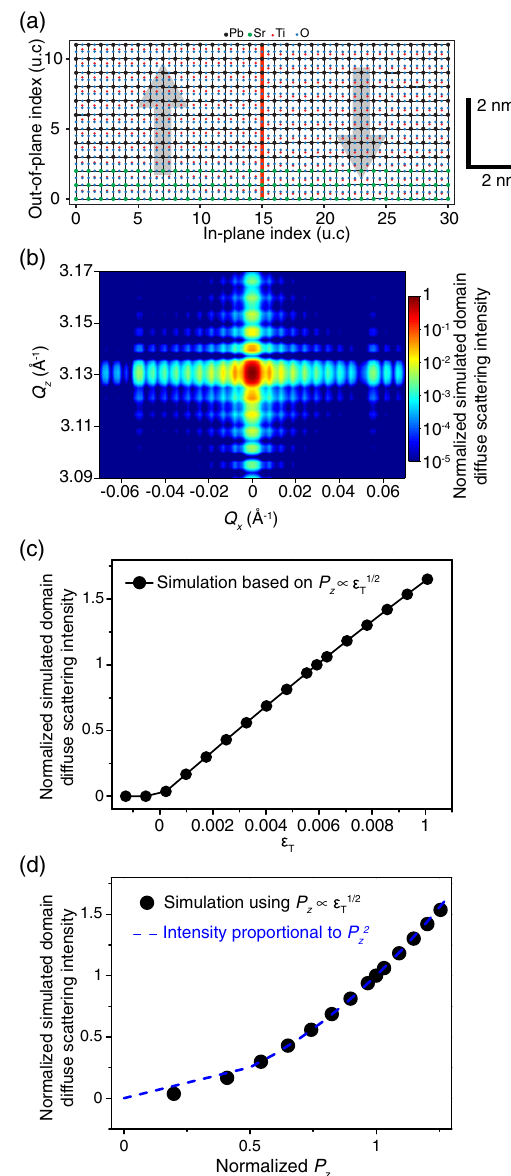
FIG. 8. (a) Atomic arrangement within a cell with a lateral size matching a single nanodomain period of one structural repeating unit of the PTO/STO SL. The solid line indicates the location of the boundary between up and down polarization regions. (b) Simulated distribution of scattered x-ray intensity in the Q x - Q z plane of reciprocal space in a region including the 002 SL Bragg reflection. Domain diffuse scattering intensity maxima appear at Q z ¼ 3 . 13 Å − 1 and Q x ¼ (cid:2) 0 . 054 Å − 1 . Fringes arising from the finite lateral size of the simulation cell appear with periodicity of approximately 0 . 007 Å − 1 along Q x . (c) Simulated normalized domain diffuse scattering inten- sity as a function of tetragonality ε T . (d) Simulated normalized domain diffuse scattering intensity as a function of polarization under conditions in which the change in the ferroelectric polarization follows ε 1 = 2 T . The dashed line in (d) is calculated using the model given in Ref. [35] in which the domain diffuse scattering intensity is proportional to the square of P z